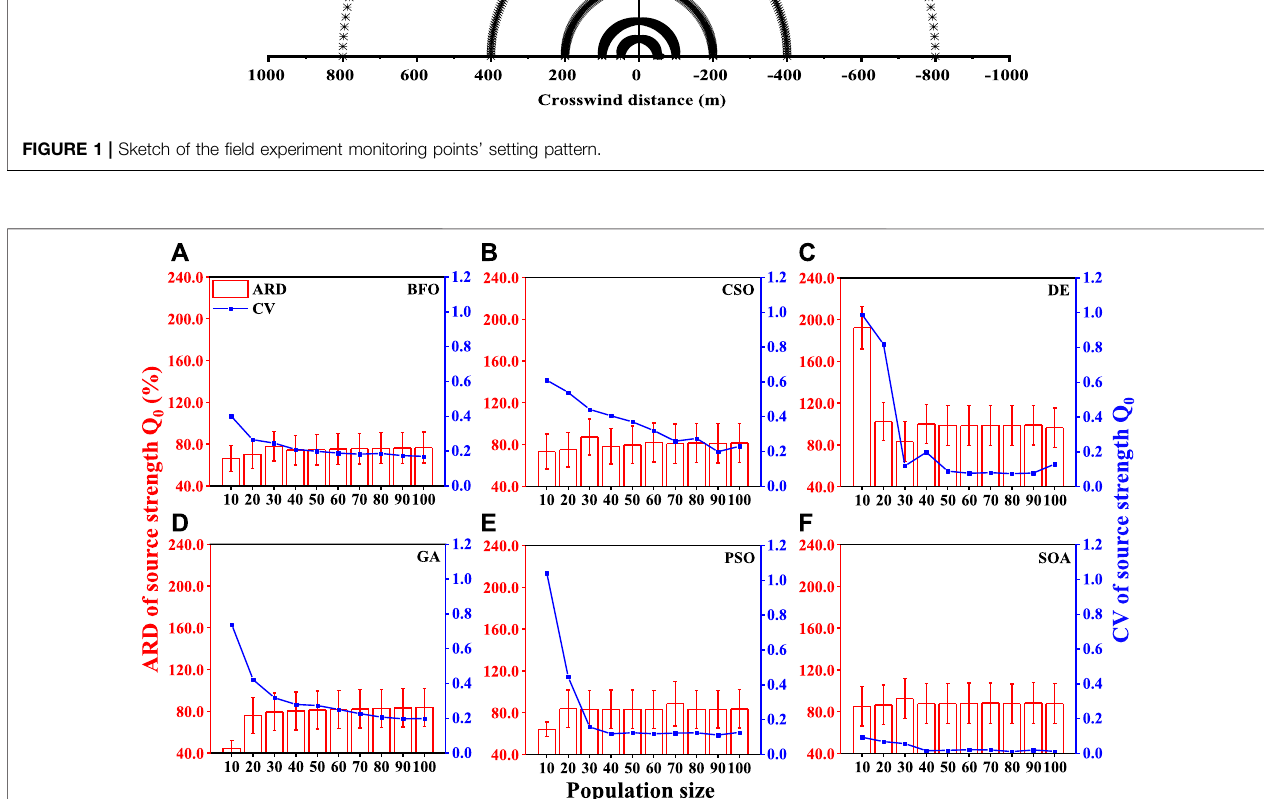
FIGURE2| Inversionperformance(ARDsandCVs)ofdifferentBIOs(BFO,CSO,DE,GA,PSO,SOA)forestimationsofsourcestrengthQ 0 undertestedpopulation sizes for different atmospheric conditions (A – F) .